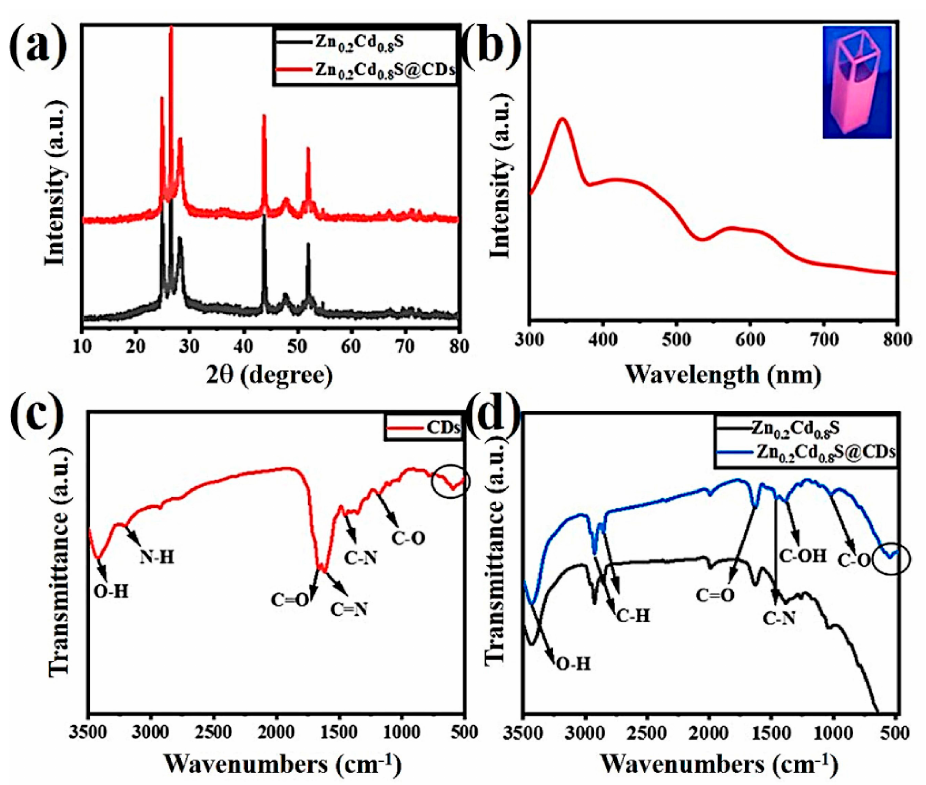
Figure 2. ( a ) XRD patterns of Zn 0.2 Cd 0.8 S and Zn 0.2 Cd 0.8 S@CDs; ( b ) UV-vis spectra of CDs; ( c , d ) FTIR spectrum of Zn 0.2 Cd 0.8 S CDs and Zn 0.2 Cd 0.8 S@CD composite. Figure 3a shows the XPS full spectrum of the Zn 0.2 Cd 0.8 S@CD complex, showing the presence of Zn, Cd, S, C, N, and O elements in the composite, which is very close to the XPS full spectrum of Zn 0.2 Cd 0.8 S (Figure S3a). In the high-resolution O 1s spectrum of Zn 0.2 Cd 0.8 S@CDs (Figure 3b), the peaks at 531.6 and 533.0 eV are attributed to the C–O and CO bonds, respectively, with some negative shifts compared to Figure S2c, and this shift may be caused by the strong electron interaction between Zn 0.2 Cd 0.8 S and CDs. In the high-resolution N 1s spectrum (Figure 3c), the peak located at 404.6 eV corresponds to the amino peak. The N 1s binding energy of Zn 0.2 Cd 0.8 S@CDs is greatly increased compared to the N 1s spectrum of CDs (Figure S2d), indicating some coupling between Zn 0.2 Cd 0.8 S and CDs. This contributes to the effective interfacial charge separation and transfer between Zn 0.2 Cd 0.8 S and CDs. Figure 3d shows that C1s can be divided into four peaks: 284.3 eV, 285.8 eV, 286.5 eV, and 288.4 eV, corresponding to a C–C/C=C bond,